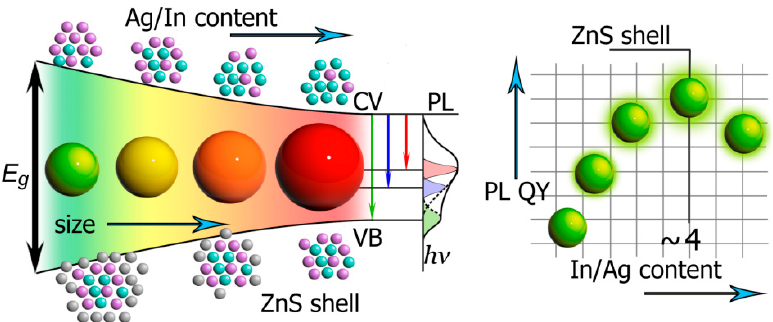
Figure 1. Representation of the tuning AIS QDs bandgap and PL quantum yield. Increasing of QD size and Ag / In content decrease bandgap energy ( E g ) and induce red shift in QD color. ZnS shell (as well as Zn-doping) works in the opposite way. The formation of broad PL spectra due to the presence of interband defect states is depicted in the middle of the sketch. Increasing In / Ag content, as well as ZnS shell growth, increase PL quantum yield (QY).